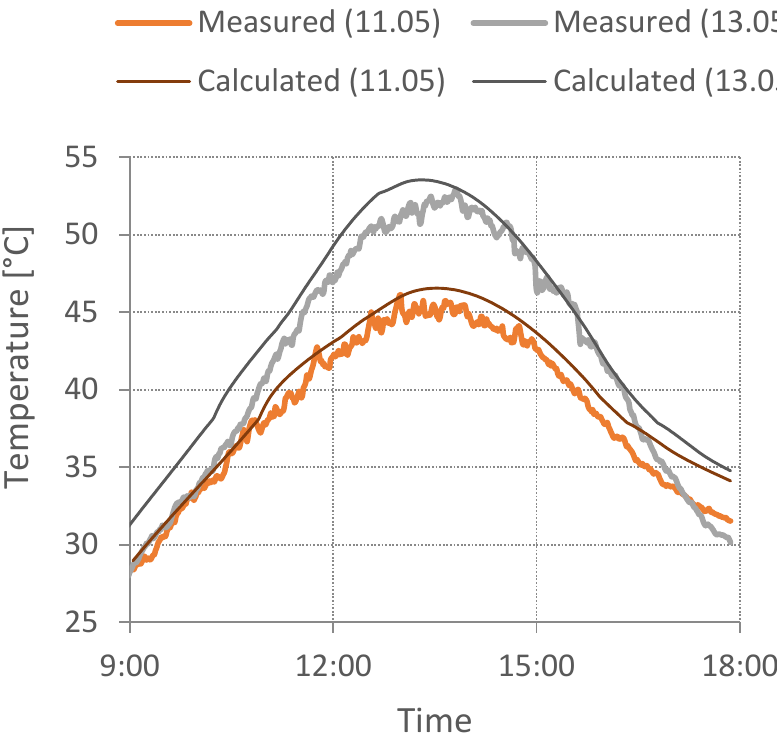
Figure 8. PV panel backside temperature values obtained by measurement and simulation.